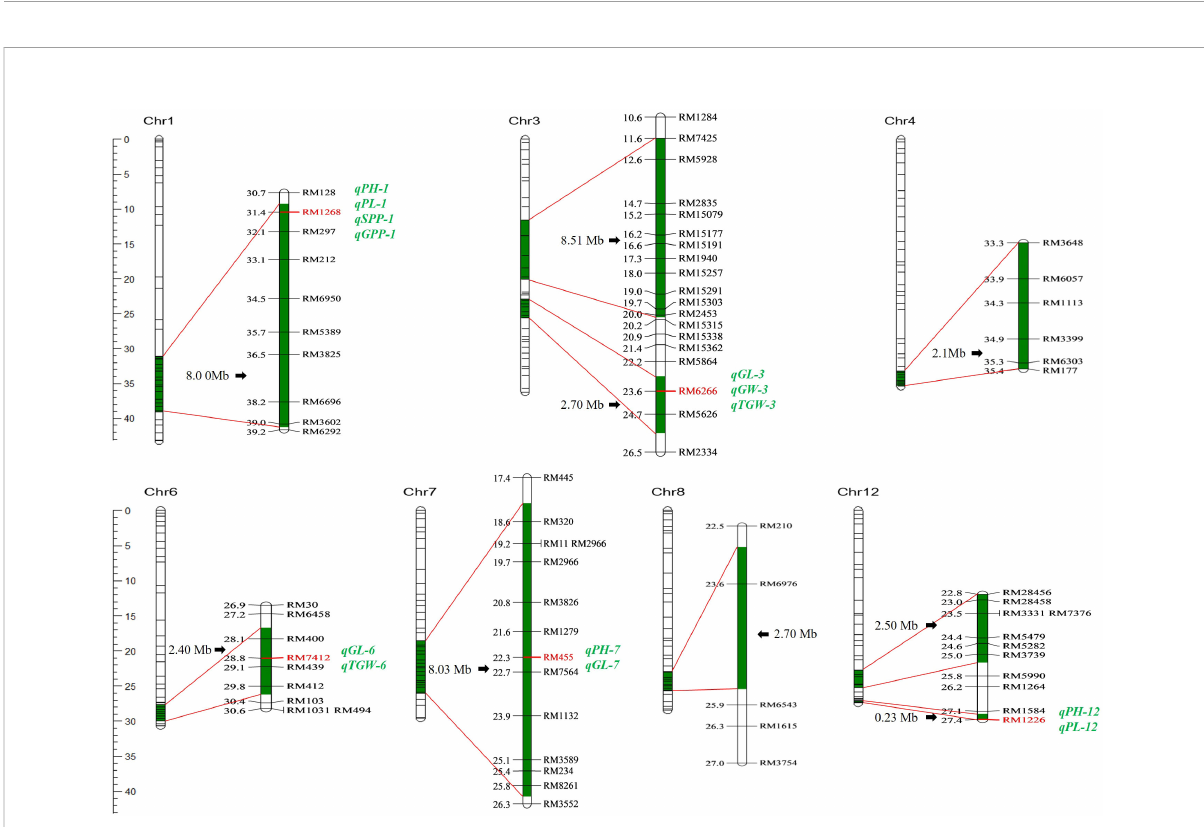
FIGURE 3 Genome distribution of substitution segments in Z1357. Substitution fragments are labeled in dark green. The left bar refers to the physical position (Mb) of markers (short lines of each Chr. bar) on seven chromosomes. All detected QTLs are listed in italics (green), and the linked marker of each QTL is listed in bold (red).